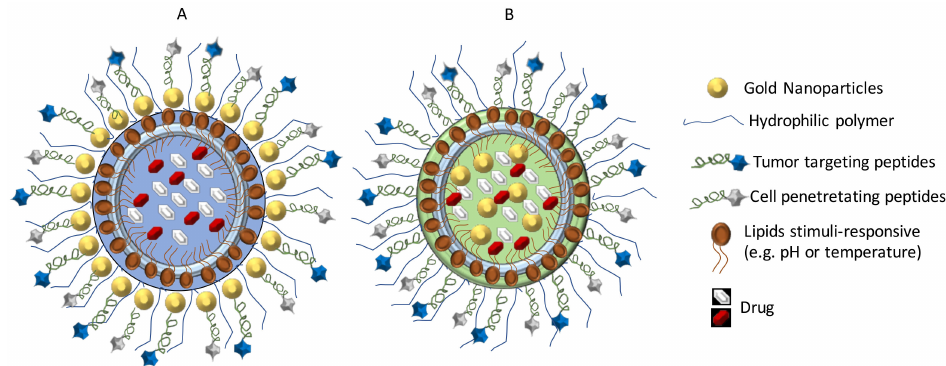
Figure 9. Two prototypes of theranostic nanoparticles, combining lipid nanoparticles and gold nanoparticles, with characteristics such as small size (<100 nm), active targeting (tumor targeting and cell penetrating peptides) and a stimuli-responsive targeting (pH or temperature): ( A ) AuNPs attached on the NPs surface by electrostatic interaction; and ( B ) AuNPs with lipophilic characteristics encapsulated in